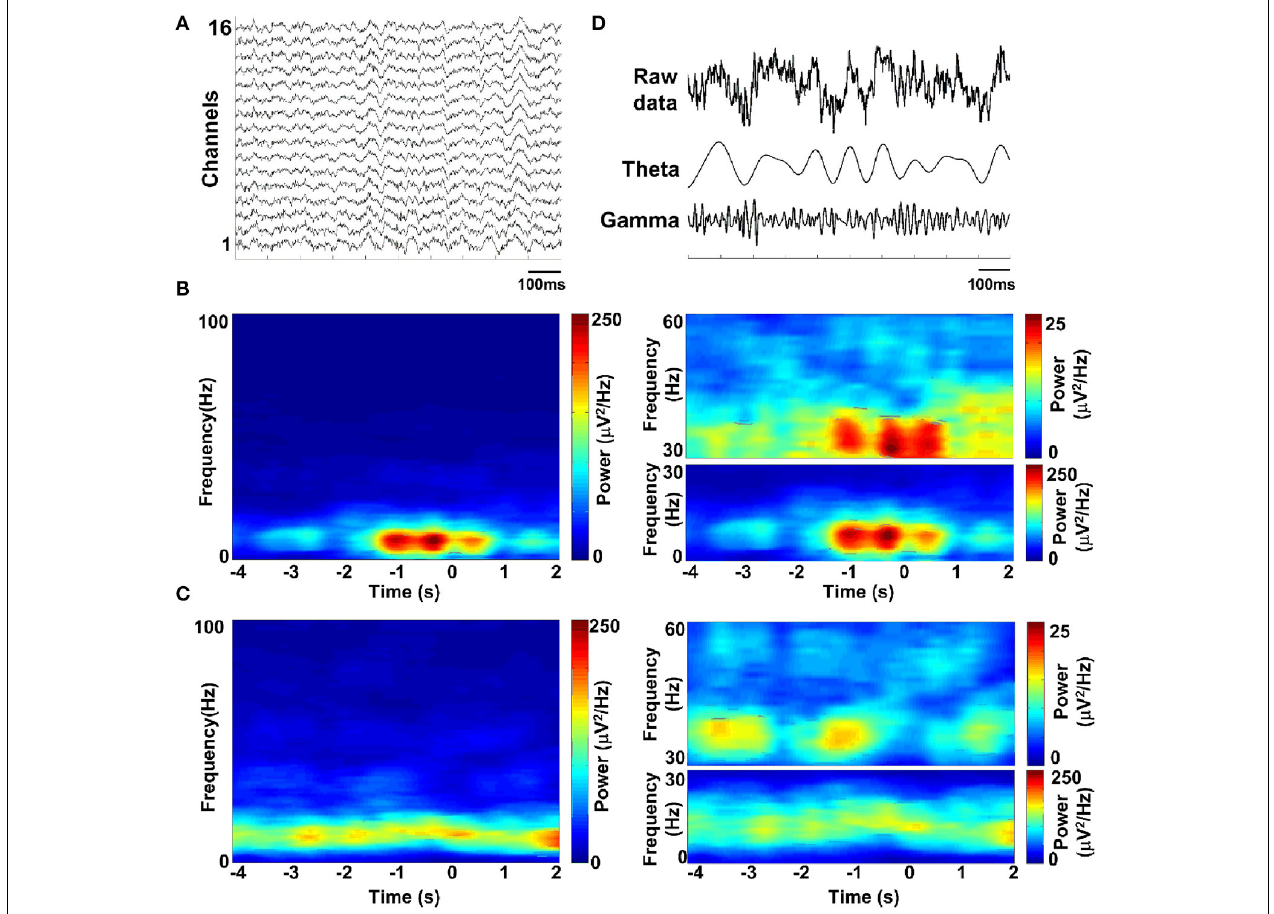
FIGURE 5 | LFP spectrograms during the working memory task. (A) Raw data recorded from rat PFC by using multi-electrodes. (B) Time-frequency power spectrum in a trial when rat got success. Shown ( B , left) is the averaged power spectrum across channels ( n = 16). Time is on the x-axis; frequency is on the y-axis. Power is indicated by color. Time 0 indicates the moment when the rat was at the choice